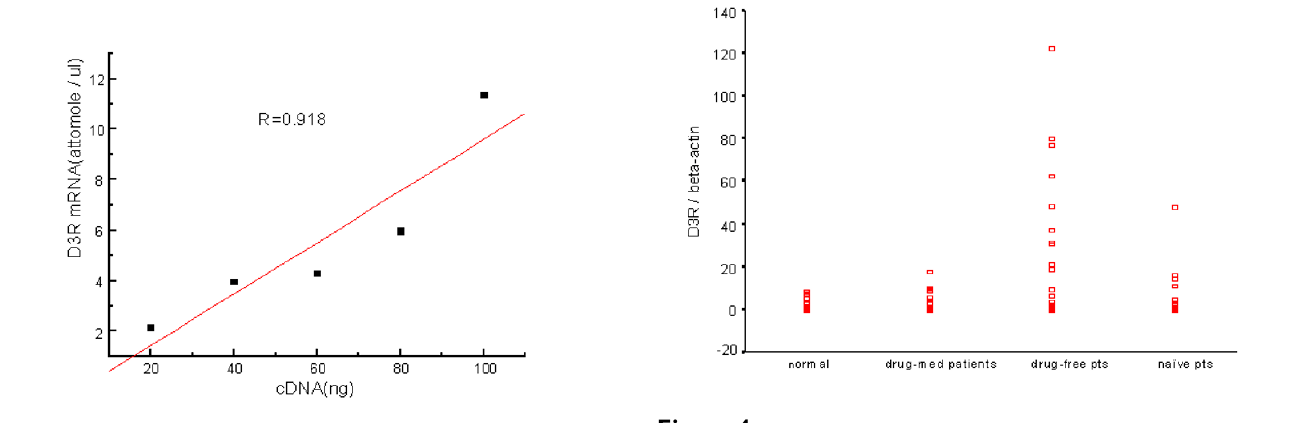
Figure 4 D3R/ β A mRNA among study groups. In drug-free patients, D3R/ β A was higher than that of normal or on-med patients. There was no difference between normal and on- med